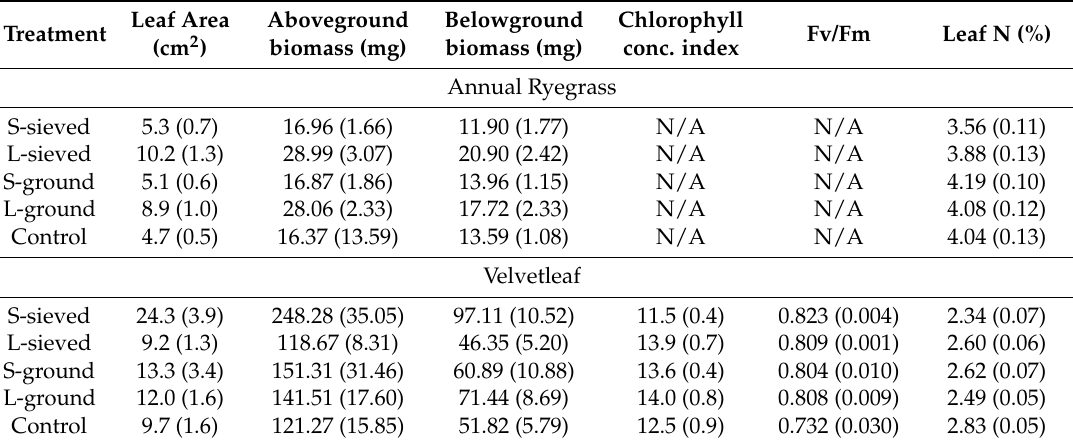
Figure 6. Leaf area growth of velvetleaf ( a ) and annual ryegrass ( b ) by treatment. Means are plotted ± 1 SE based on measurements on 7 replicates for each treatment by species combination. Table 2. Plant responses for annual ryegrass and velvetleaf. S-sieved, L-sieved, S-ground, and L-ground stand for small sieved biochar, large sieved biochar, small ground biochar, and large ground biochar, respectively. Means are listed with standard errors in parentheses.